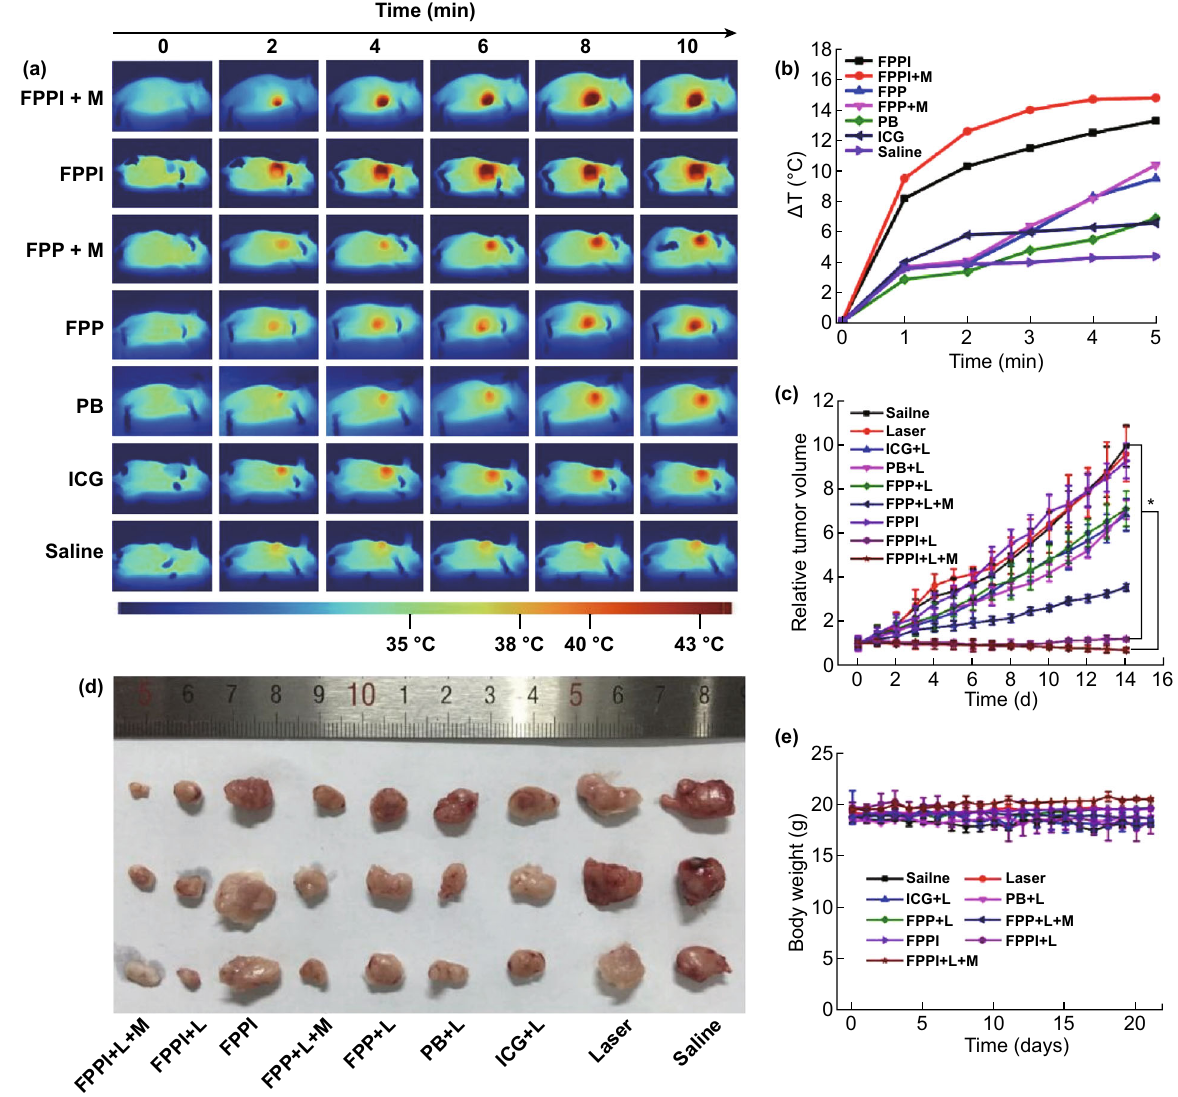
Fig. 7 a Changes in mouse body shell temperature under NIR laser irradiation over 10 min measured by infrared imaging at 24 h post-injection; b local peak temperature elevation in the tumor region during laser irradiation corresponding to a ; c change in tumor volume over time in each group after laser-activated treatment; d photographs of the excised tumors in different groups at day 14 post-injection; e variation of mouse body weight over time in each group after various